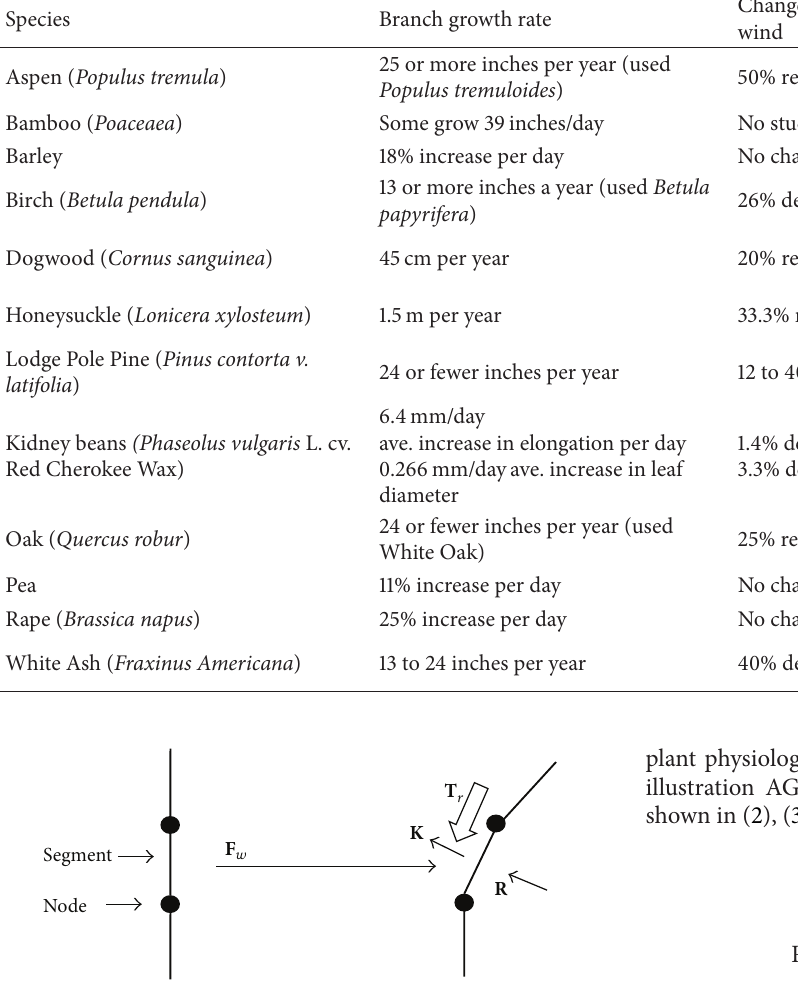
Figure 1: Branch